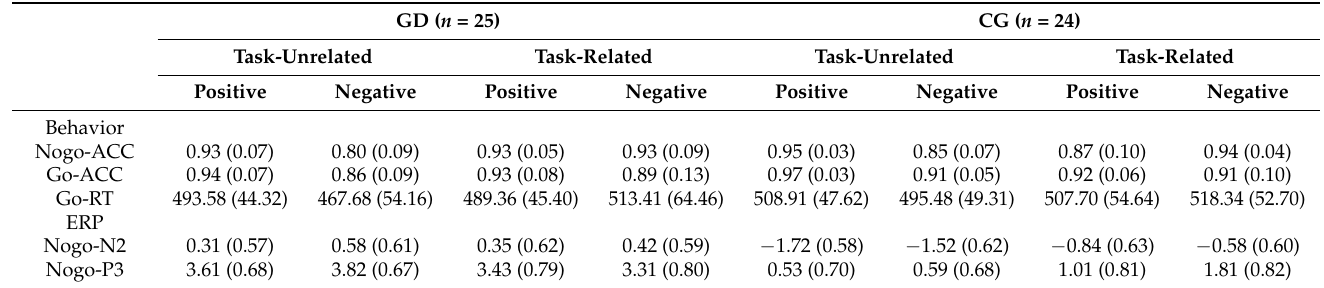
Table 2. Behavioral and EEG descriptive results in different